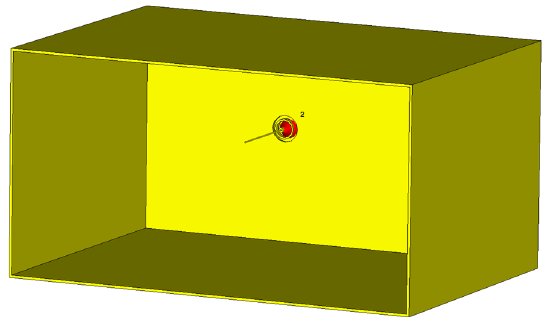
Figure 4. Open cavity without transmitter antenna used in the back-propagation phase. Geometry of the 3D problem.